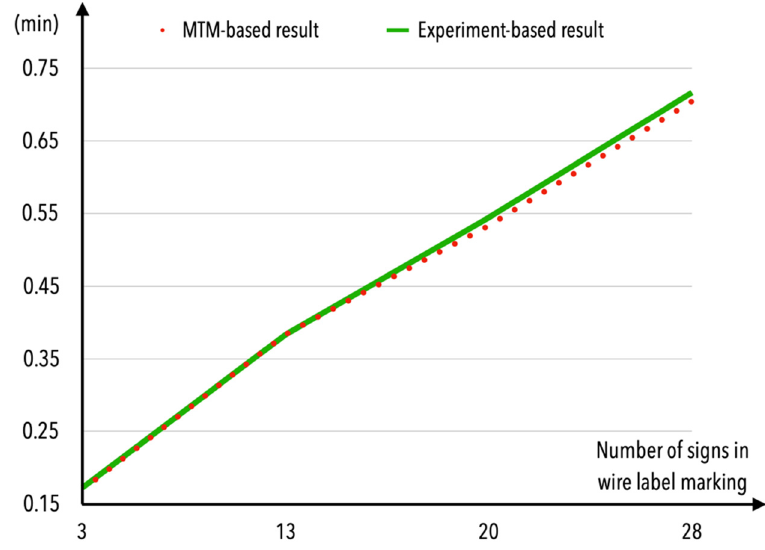
Figure 18. Validation of MTM-based results with experiment-based results.